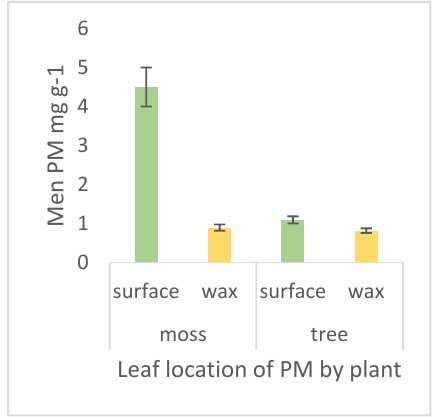
Figure 5. Location of total PM on plant leaves comparing surface PM with that trapped in and extracted from wax from nine sites on an urban gradient. PM is measured in mg per g dry weight. Error bars are ± 1 standard error.